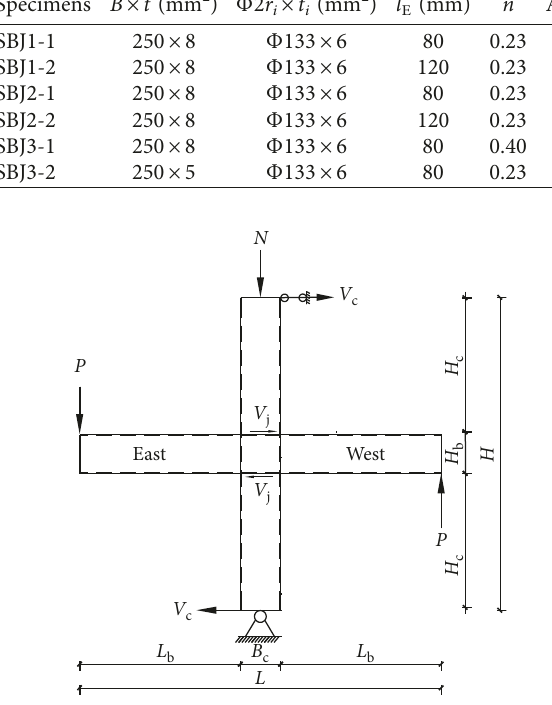
Figure 1: Force diagram in panel